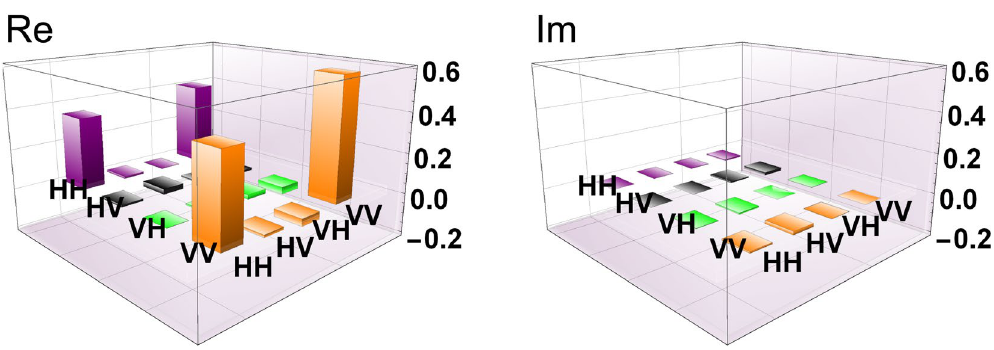
Figure 4. The reconstructed density matrix ρ AB for T =